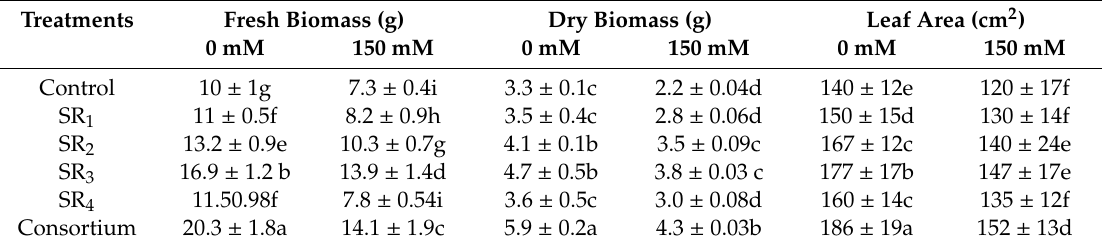
Table 3. E ff ect of inoculation of halotolerant PGPR on the fresh and dry biomass and leaf area of wheat plants grown under salinity